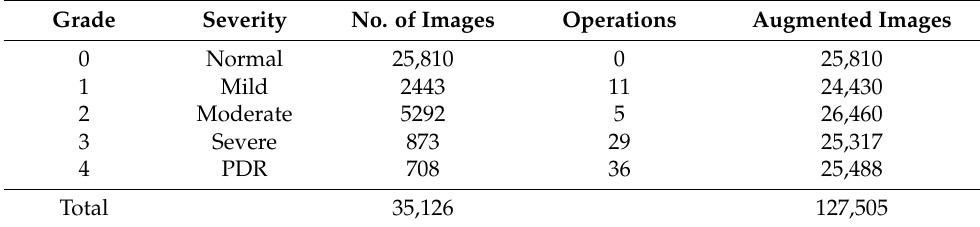
Table 2. The dataset statistics by using data augmentation operations.